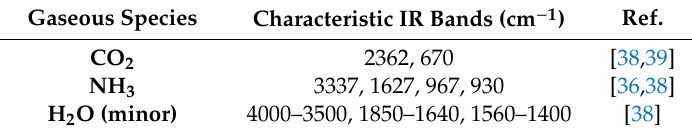
Table 2. Assignment of FTIR absorption bands of urea phosphate before and after TG-FTIR.